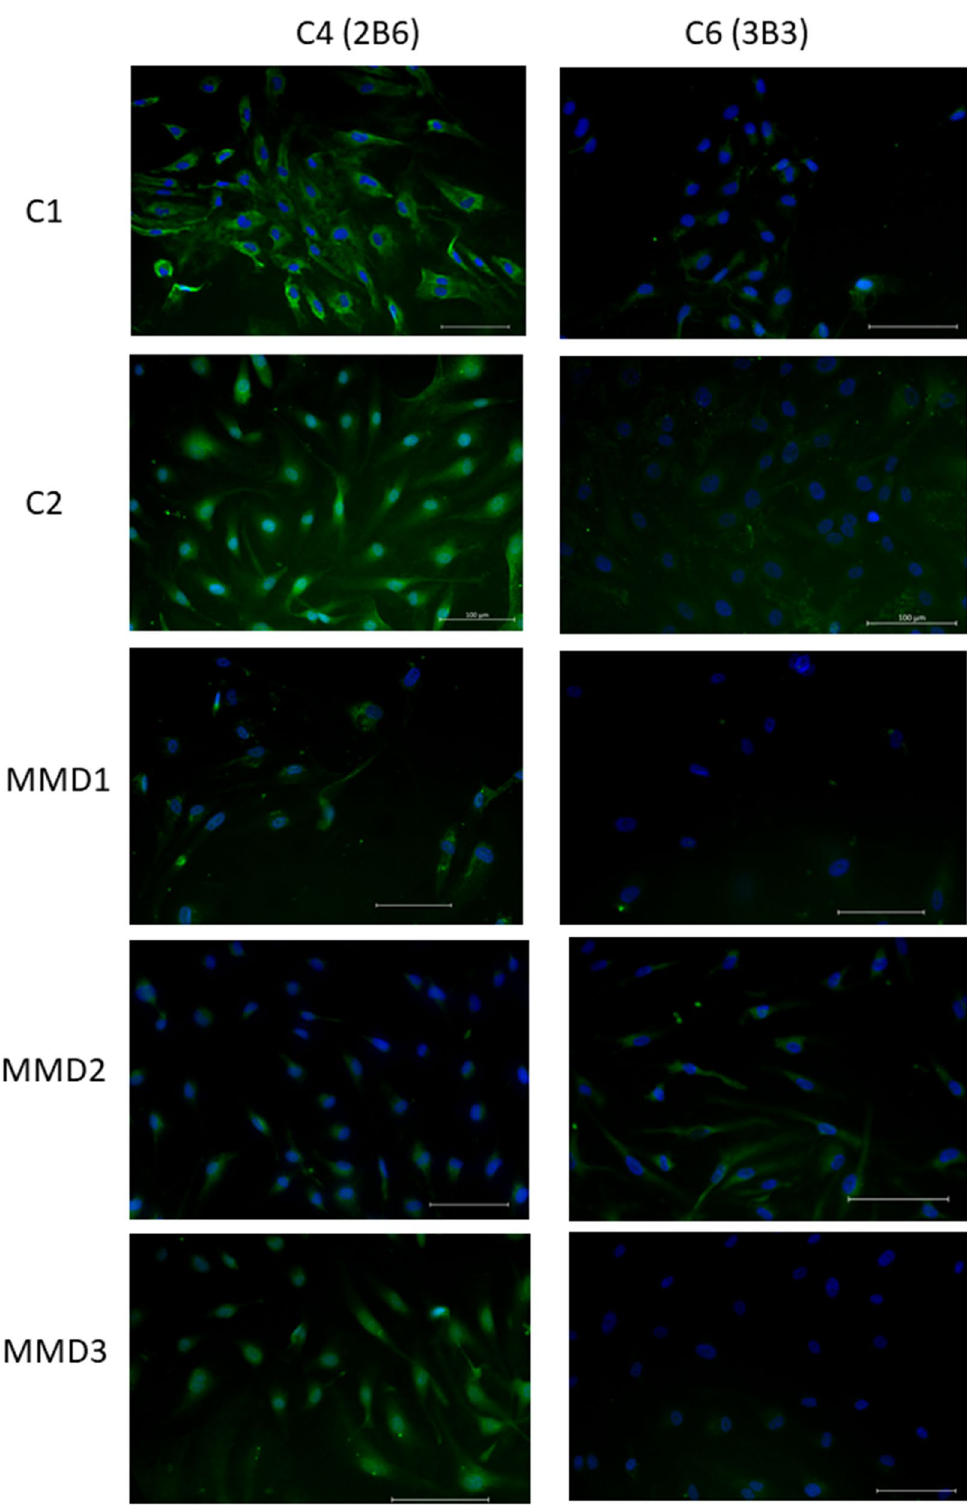
Figure 6. Immunofluorescence for CS-C4 and CS-C6 in endothelial cells derived from MMD and control. MMD1 and MMD2 showed decreased expression of CS-C4 comparing controls. CS-C6 expression was also decreased in MMD1 and MMD3. Scale bar: 100